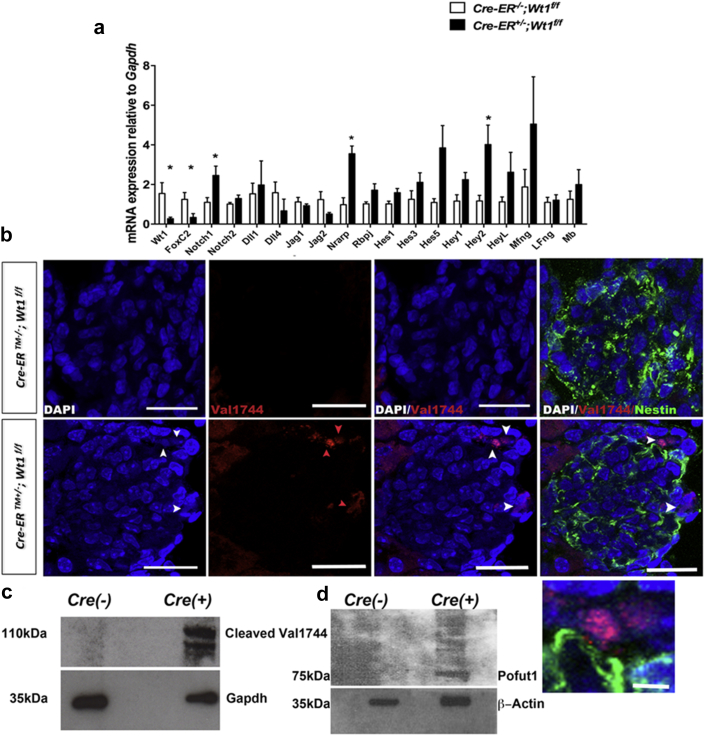
Notch activation coincides with onset of glomerulosclerosis in in CAGG-CreERTM−/+;Wt1f/ftransgenic mice following tamoxifen administration. (a) Relative mean transcript levels of Notch pathway components in primary podocytes of mutants compared with controls at day (D) 6 post-induction (PI). Bars represent means and error bars represent SDs. CAGG-CreERTM−/−;Wt1f/f (n = 6) versus CAGG-CreERTM+/−;Wt1f/f (n = 10): mean Notch1, 1.1 ± 0.2 versus 2.5 ± 0.5, *P = 0.05; mean Nrarp, 0.9 ± 0.4 versus 3.6 ± 0.4, **P = 0.001; mean Rbpsuh, 1.0 ± 0.1 versus 1.7 ± 0.3, P = 0.09; mean Hes1, 1.0 ± 0.1 versus 1.6 ± 0.2, P = 0.09; mean Hes3, 1.3 ± 0.4 versus 2.1 ± 0.5, P = 0.25; mean Hes5, 1.0 ± 0.2 versus 3.9 ± 1.1, P = 0.07; mean Hey1, 1.1 ± 0.3 versus 2.2 ± 0.4, P = 0.11; mean Hey2, 1.2 ± 0.3 versus 4.0 ± 1, *P = 0.04; mean HeyL, 1.1 ± 0.2 versus 2.3 ± 0.5, P = 0.14; mean MFng, 1.9 ± 0.9 versus 5.0 ± 2.4, P = 0.19; mean FoxC2, 1.2 ± 0.4 versus 0.3 ± 0.2, *P = 0.04, Student t-test. (b) Shown are representative images of glomeruli following double immunofluorescence labeling of D6 PI mouse kidney sections with anticleaved Notch1 (Val1744) and anti-Nestin of CAGG-CreERTM−/−;Wt1f/f (controls) and CAGG-CreERTM+/−;Wt1f/f (mutants) transgenic mice following multichannel labeling with Alexa Fluor 488–conjugated secondary antibody (Nestin, demarcates podocytes) and Alexa Fluor 594–conjugated secondary antibody (cleaved Notch1). Sections are counterstained with DAPI. Arrows show positive cleaved Notch1 nuclear staining in mutant glomeruli within Nestin-positive cells that are not evident in control glomeruli. Bars = 50 μm. Inset shows high-power view of same cells. Bar = 10 μm. (c,d) Representative images of Western blot analyses of protein derived from primary podocytes isolated from mutants and control mice. Immunoblots show that cleaved Notch1 (Val1744) (c) and Pofut1 (d) are expressed at D6 PI in mutant podocytes but not in controls. To optimize viewing of this image, please see the online version of this article at www.kidney-international.org.